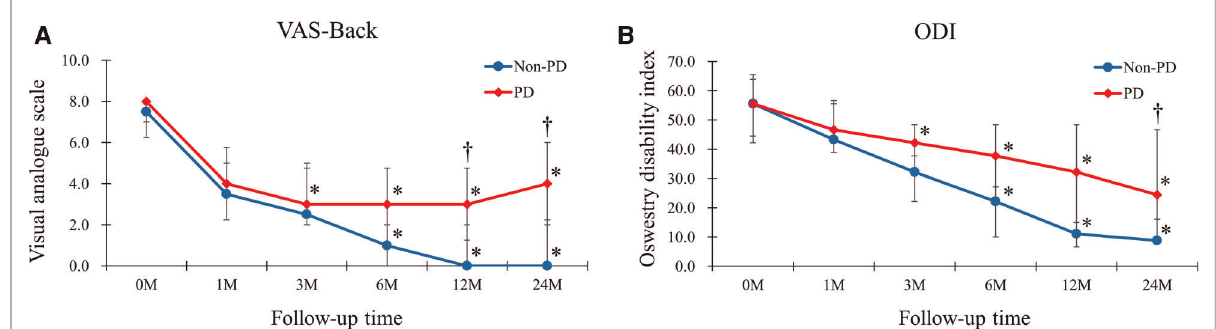
FIGURE 3 The VAS-Back and ODI of the Non-PD and PD groups. ( A ) Patients in the Non-PD group had better results than those of PD group in the VAS-Back at 12-months and 24-months postoperatively (0.00 vs. 3.00 postoperatively at 12-months, p = 0.030; 0.00 vs. 4.00 postoperatively at 24-months, p = 0.009). ( B ) The ODI at 24-months postoperatively showed better improvement in the Non-PD group (8.89 vs. 24.44, p =